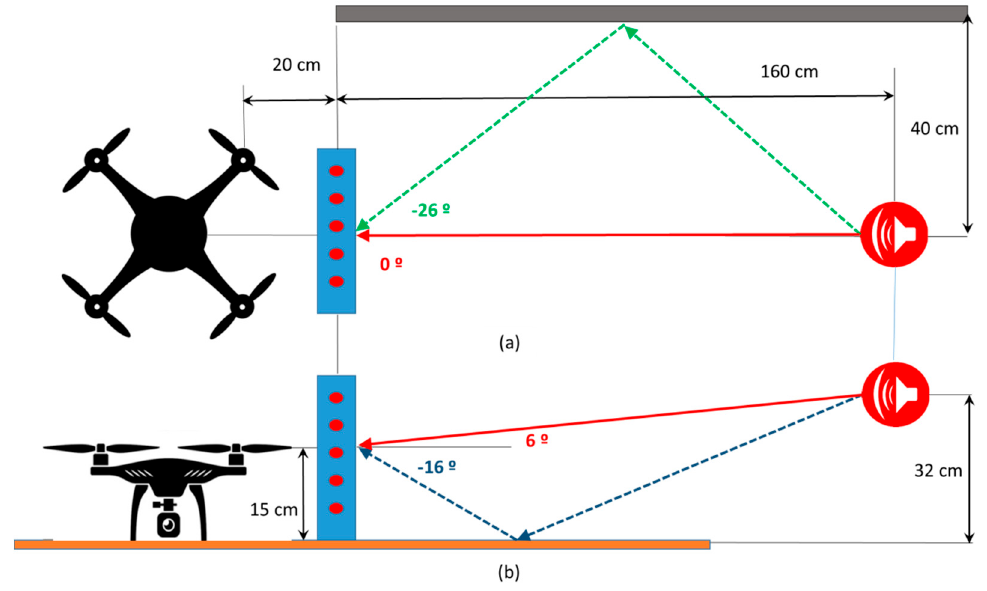
Figure 11. Elements distribution on Setup 3: ( a ) elevation view, ( b ) profile view.